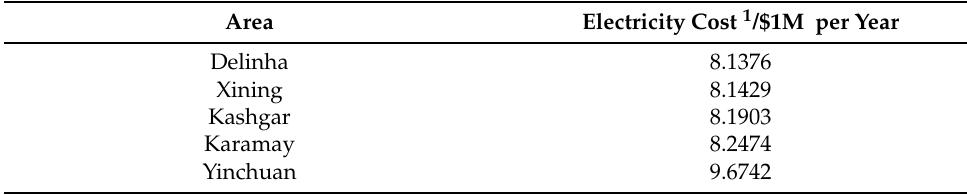
Table 5. Top 5 estimated average annual electricity cost of data centers in various